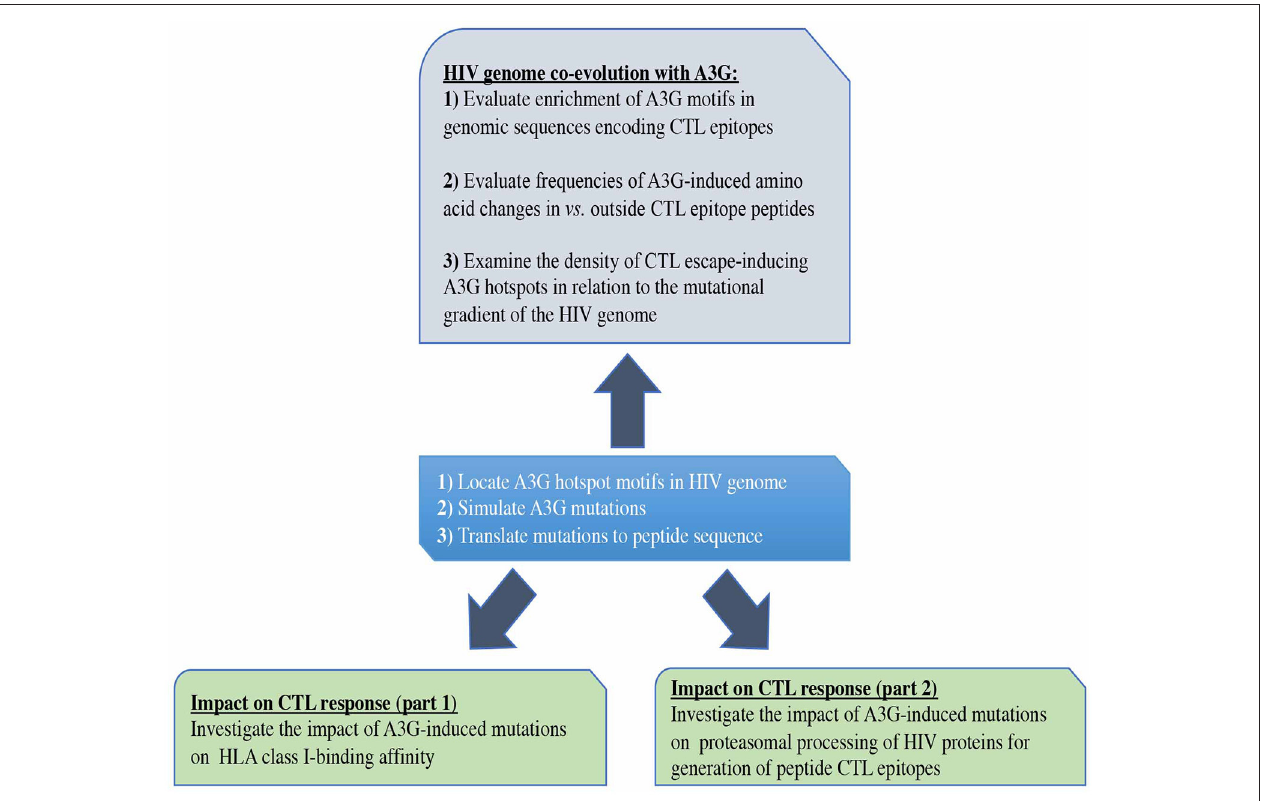
FIGURE 1 | Study design. First, we predicted all possible CTL epitopes of Gag, Pol, Env, and Nef restricted to HLA-A2:01, HLA-A3:01, HLA-B57:01, and HLA-B35:01, simulated A3G-mediated mutations in HIV genomic sequences encoding these epitopes and translated these into peptide mutations (central box). We evaluated the potential impact of A3G-induced mutations on generation of CTL epitopes (lower boxes). We also examined whether potential for CTL escape has left an evolutionary imprint on the HIV genome by studying the pattern and distribution of A3G hotspots across the HIV genome, in the context of their potential for facilitating the generation of CTL escape mutants (Top